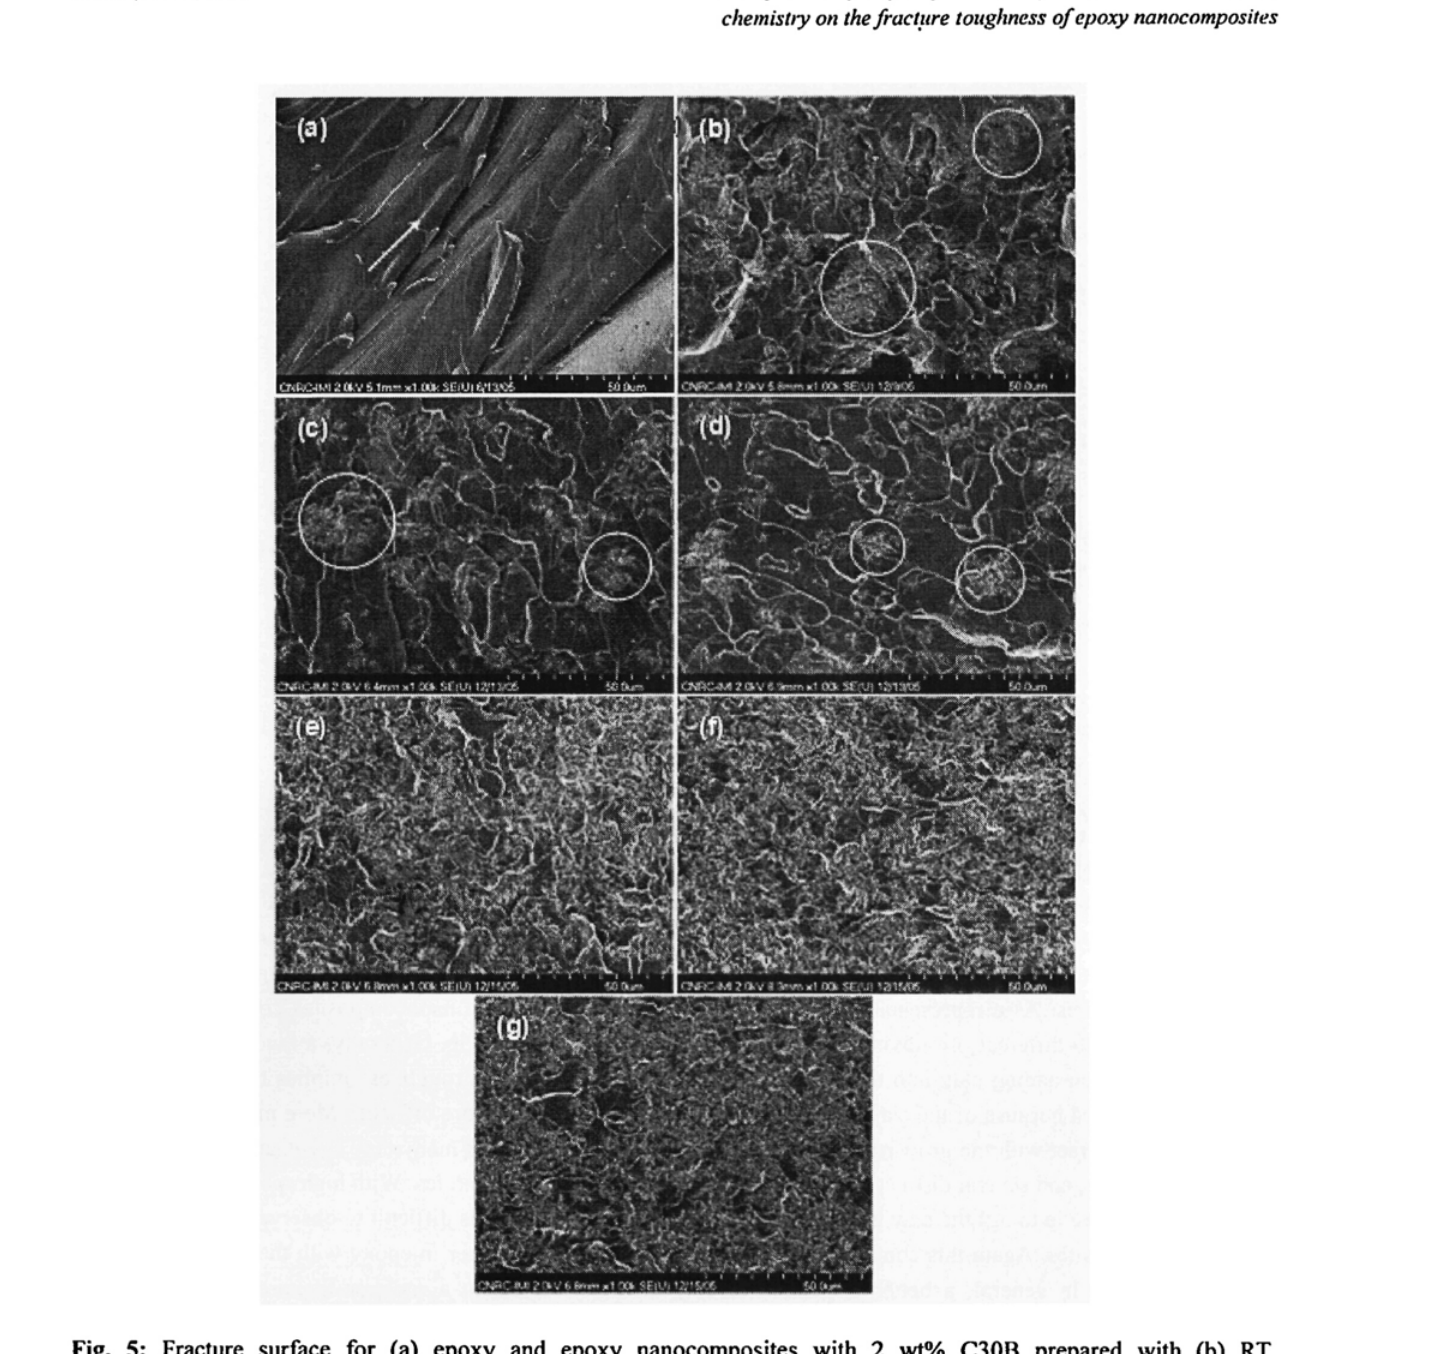
Fig. 5: Fracture surface for (a) epoxy and epoxy nanocomposites with 2 wt% C30B prepared with (b) RT, (c) Tm, (d) TM, (e) RS, (0 TS, and (g)